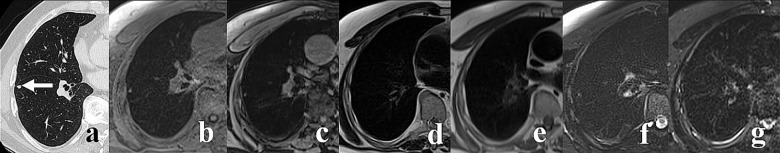
A 62-year-old man with 5.6 mm pulmonary nodule in the right lower lobe (arrow).The lesion is seen on CT (A) as well as on T1 VIBE (B), T1 out-of-phase (C) and T2 SPIR (F) images, whereas T2 TSE (D), T2 HASTE (E) and T2 STIR (G) images were negative.